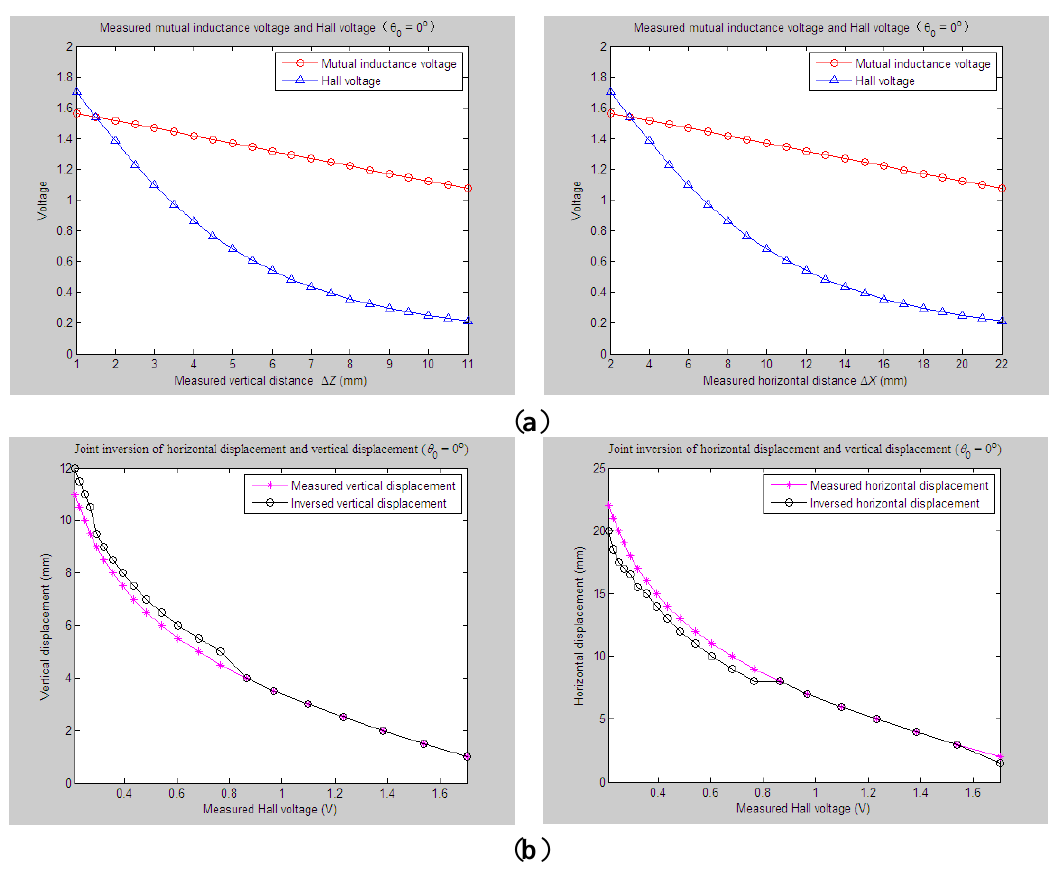
Figure 16. Horizontal and vertical displacement joint inversion results when both measured Δ Z and Δ X are changed ( θ 0 = 0°). ( a ) Measured mutual inductance voltage and Hall voltage; ( b ) inversed horizontal and vertical displacements.